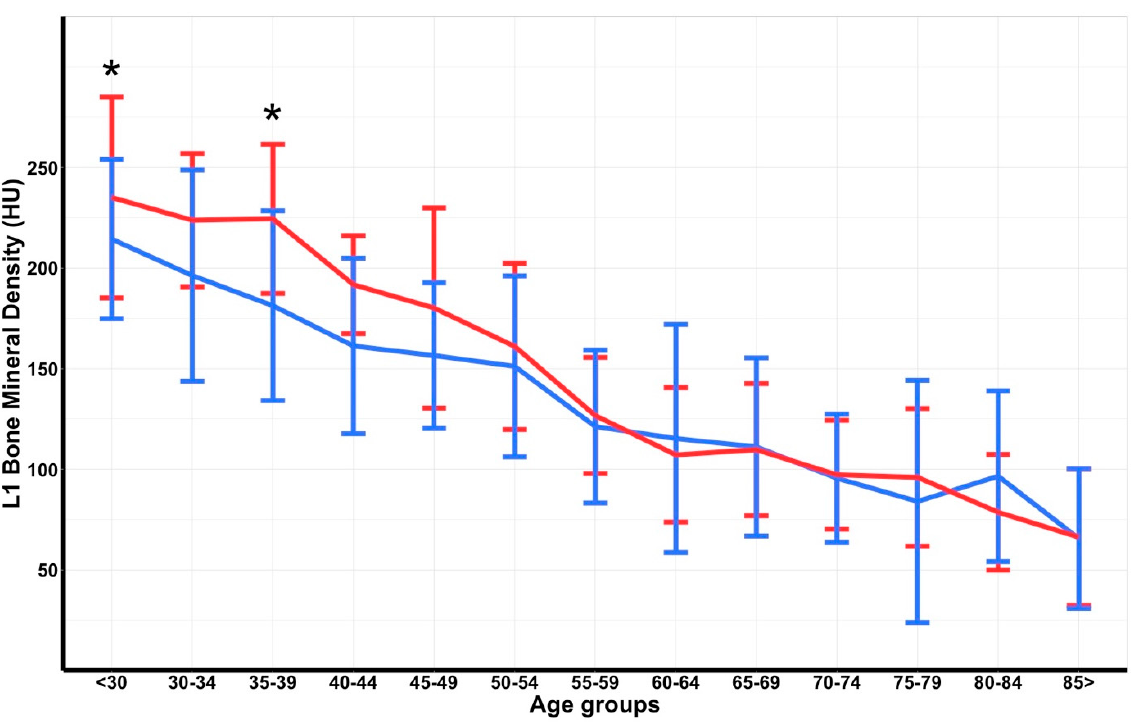
Figure 2. Errorbar plot of bone mineral density (in Hounsfield Units [HU]), displayed in mean and standard deviation, with comparison line graphs of means per 5-year interval showing men (blue) versus women (red) in the Dutch trauma cohort. The asterisk indicates statistical significance.